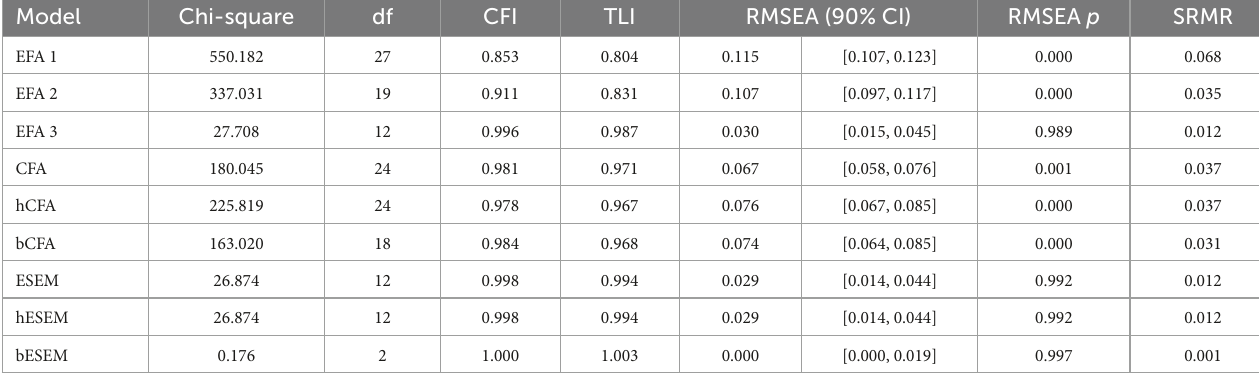
TABLE 3 Goodness-of-fit of all models.